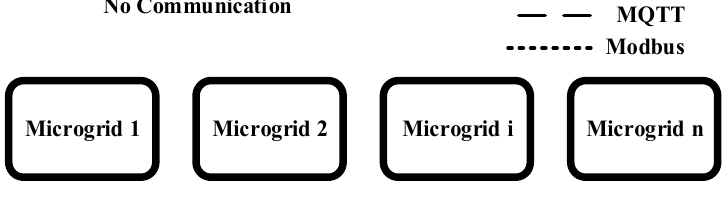
Figure 10. No communication mode.